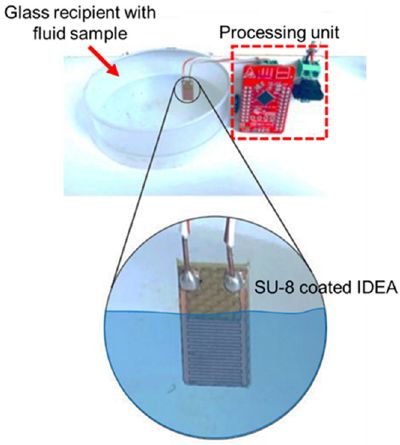
Figure 5. Experimental setup.